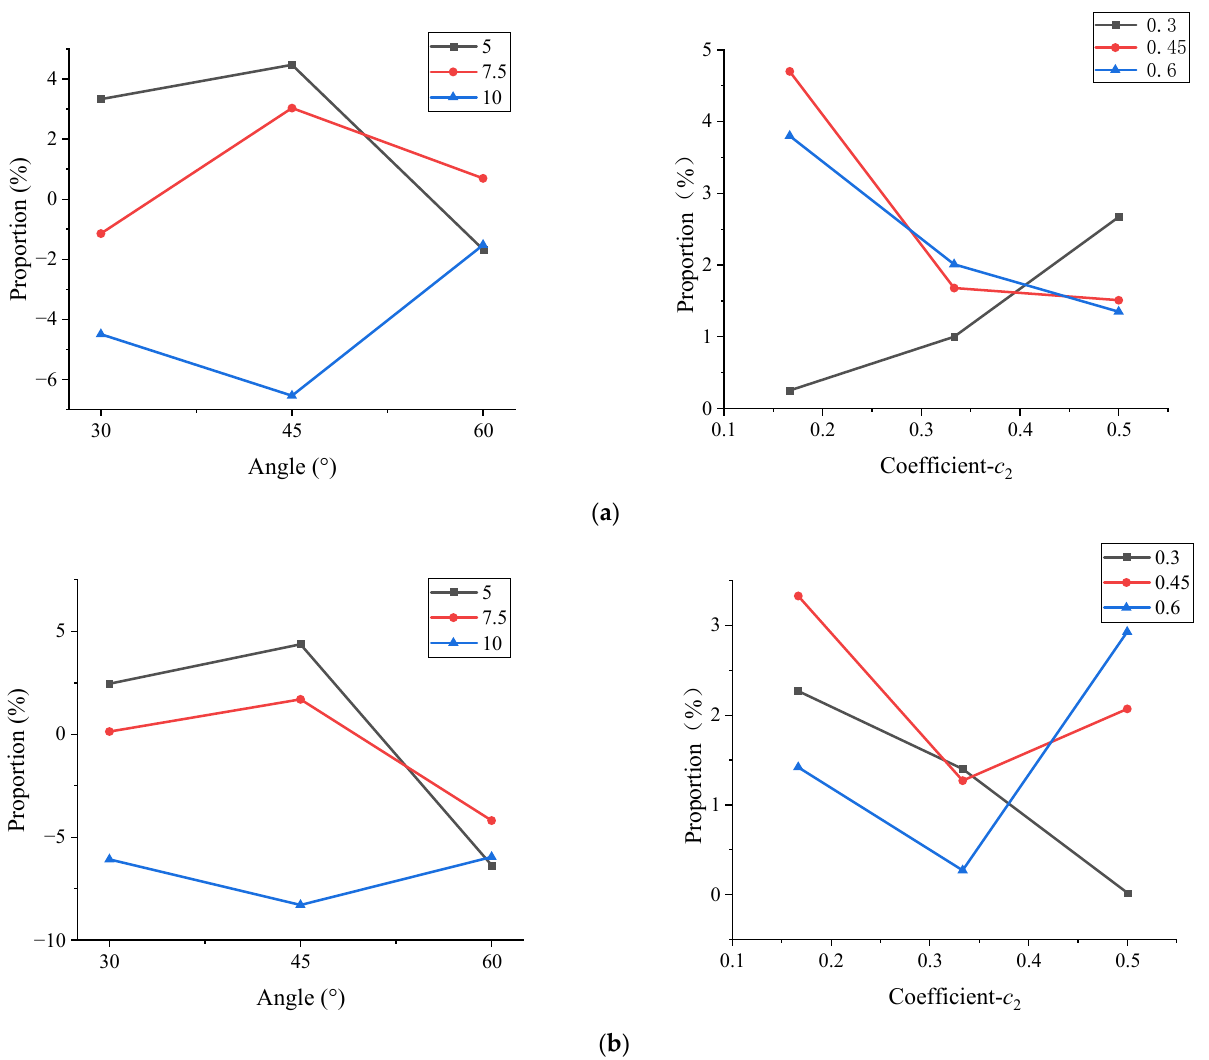
Figure 10. Influence of the reflux groove structure on the inlet side: ( a ) change in the inhomogeneity of the inlet flow; ( b ) change in the inlet pressure pulsation coefficient.